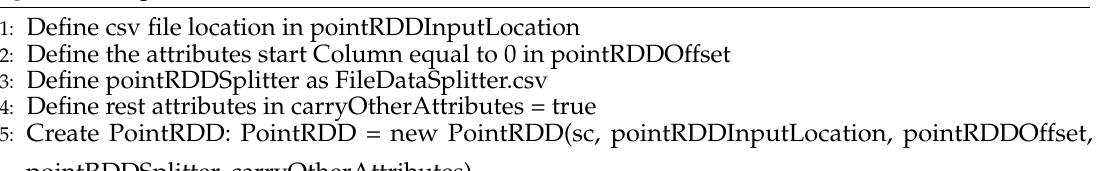
Algorithm 2 Spatial PointRDD Creation